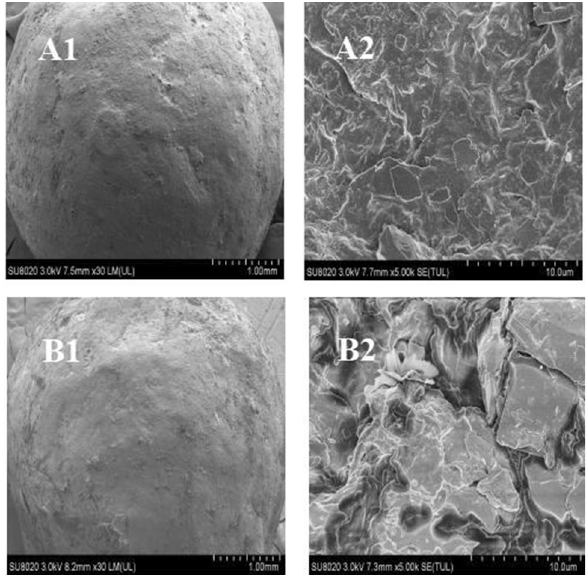
Figure 4. Scanning electron micrographs of (A1-1 mm and A2-10 µm) CRU before release and (B1-1 mm and B2-10 µm) CRU after